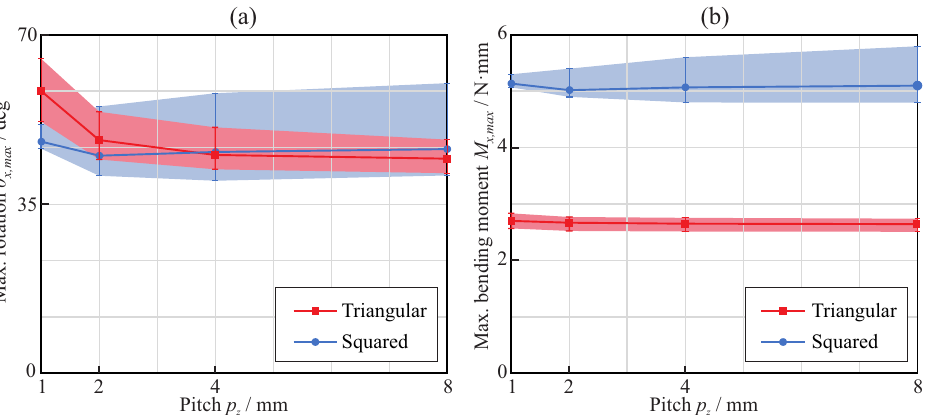
Figure 7. Bending analysis: effect of the pitch on the maximum rotation ( a ) and maximum applied torque ( b ) when the end of the martensitic elastic regime is